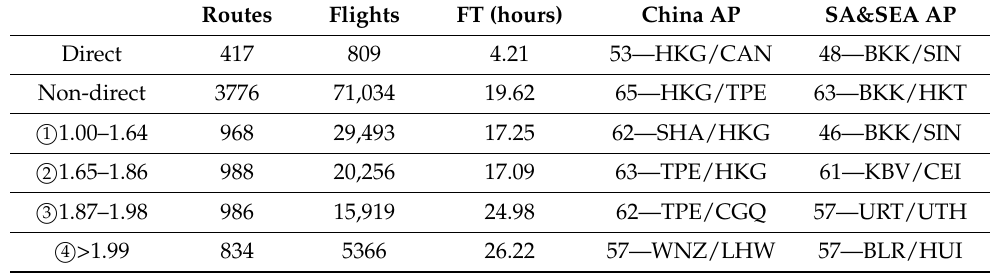
Table 2. Direct and non-direct flight route information, including daily average number of routes, daily average number of flights, average flight time (FT), and the involved number of China airports (AP) and SA&SEA airports (including two airports (IATA codes) with the largest total number of flights). The non-direct flights were divided into four categories according to the average number of flight routes, with a different number of layovers ① – ④ .